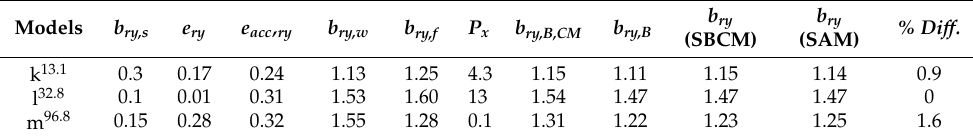
Table 4. Summary of the ‘ b ry ’ value calculated for the asymmetrical models from the proposed SBCM and comparison with the results from the